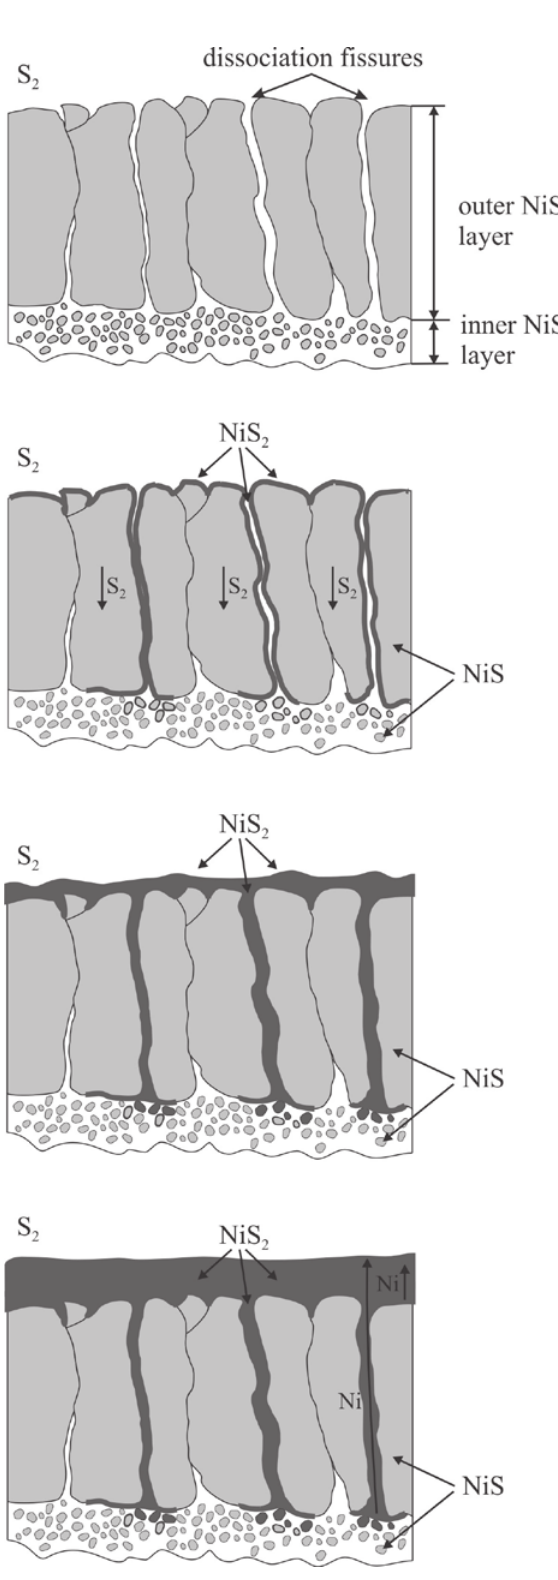
Fig. 10: Gradual overgrowth of dissociation fissures in the NiS substrate by the NiS 2 reaction product